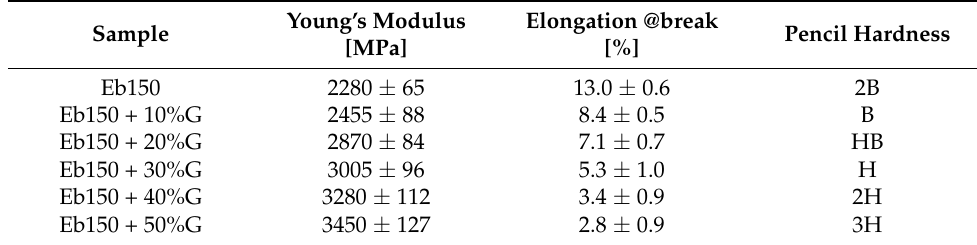
Table 5. Young’s modulus, elongation at break and pencil hardness values for the investigated UV-LED cured